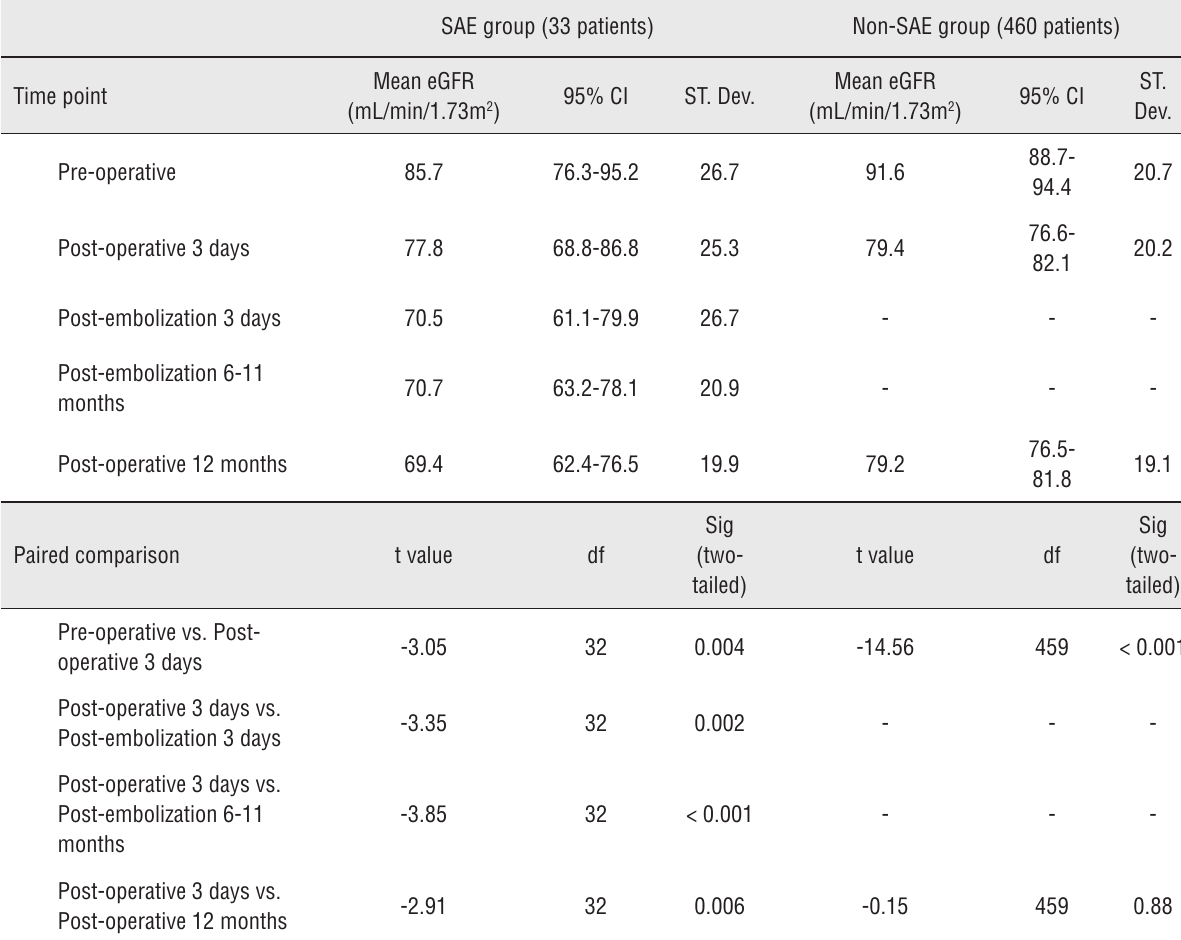
Table 3 - Mean eGFR values and paired comparison at different time points before surgery, before and after